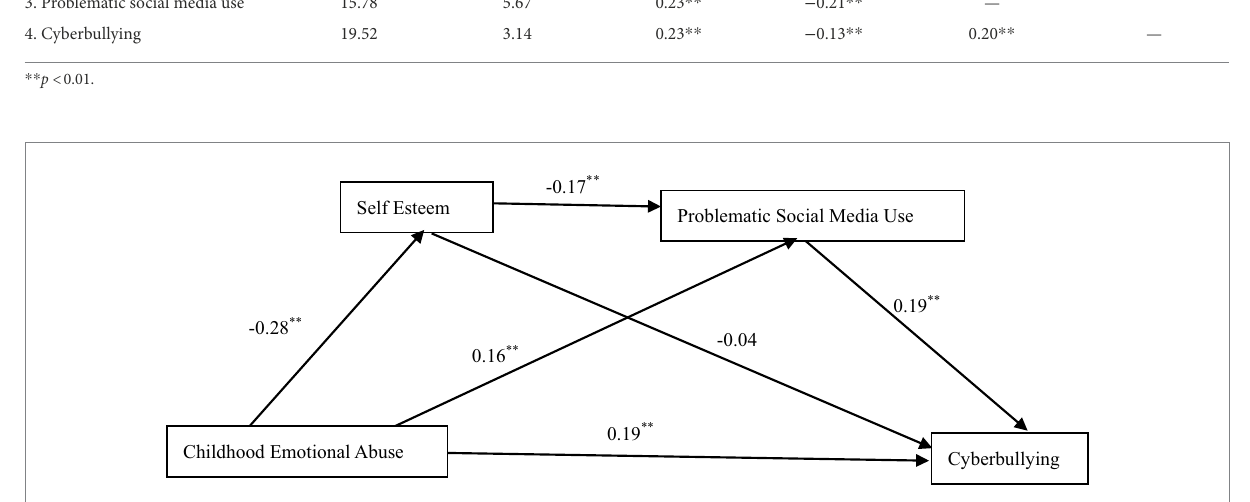
FIGURE 1 Model of the chained mediating effect of self-esteem and problematic social media use. ** p < 0.01.